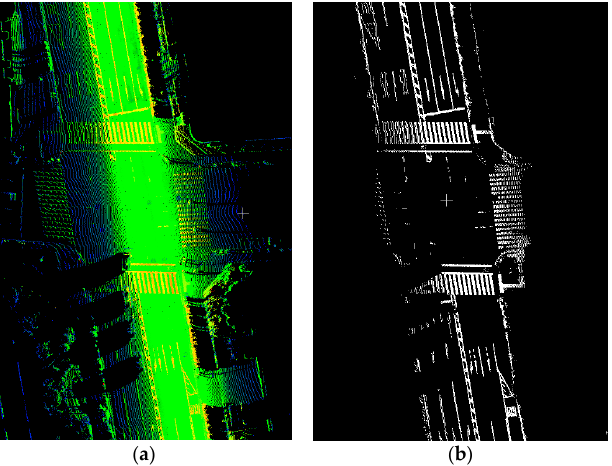
Figure 12. Road marking extraction from MMS point cloud: ( a ) original MMS point cloud (the color represents the original intensity); and ( b ) the result of road marking extraction.